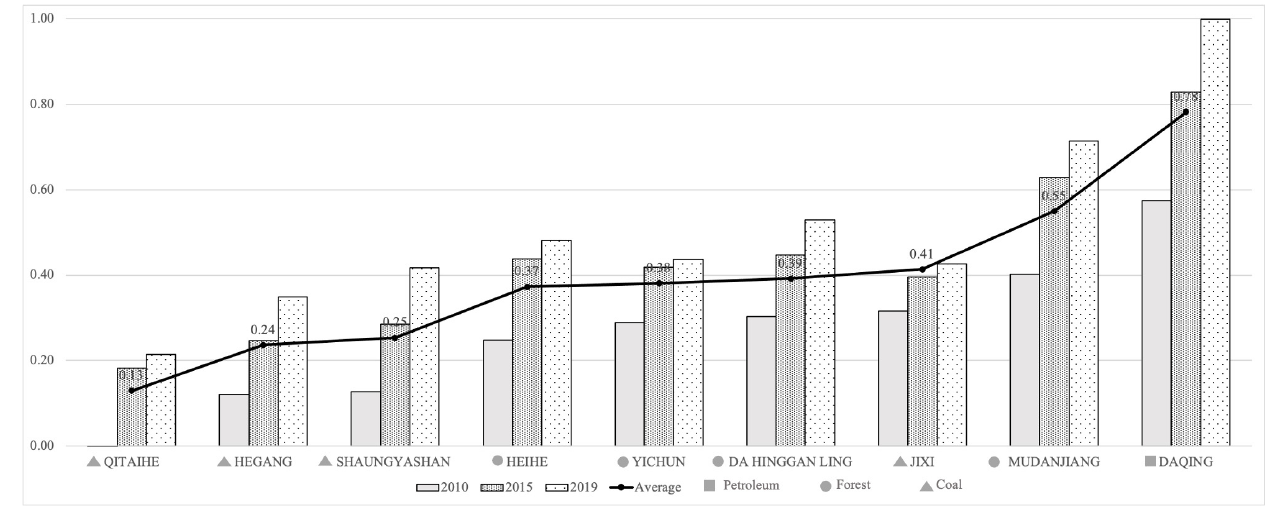
Figure 4. Overall resilience values of 9 RBCs in 2010, 2015, 2019, and 10-year average.